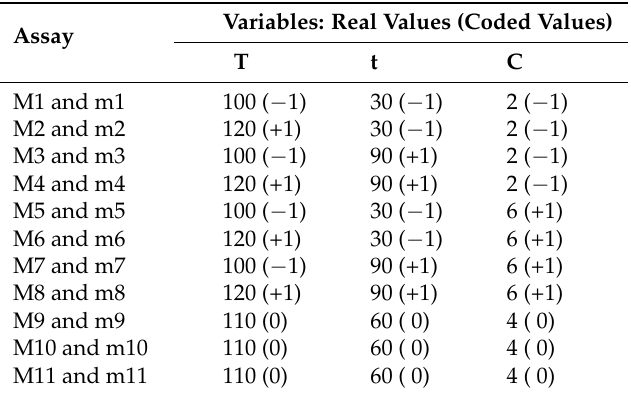
Table 1. Matrix of the experimental factorial design.